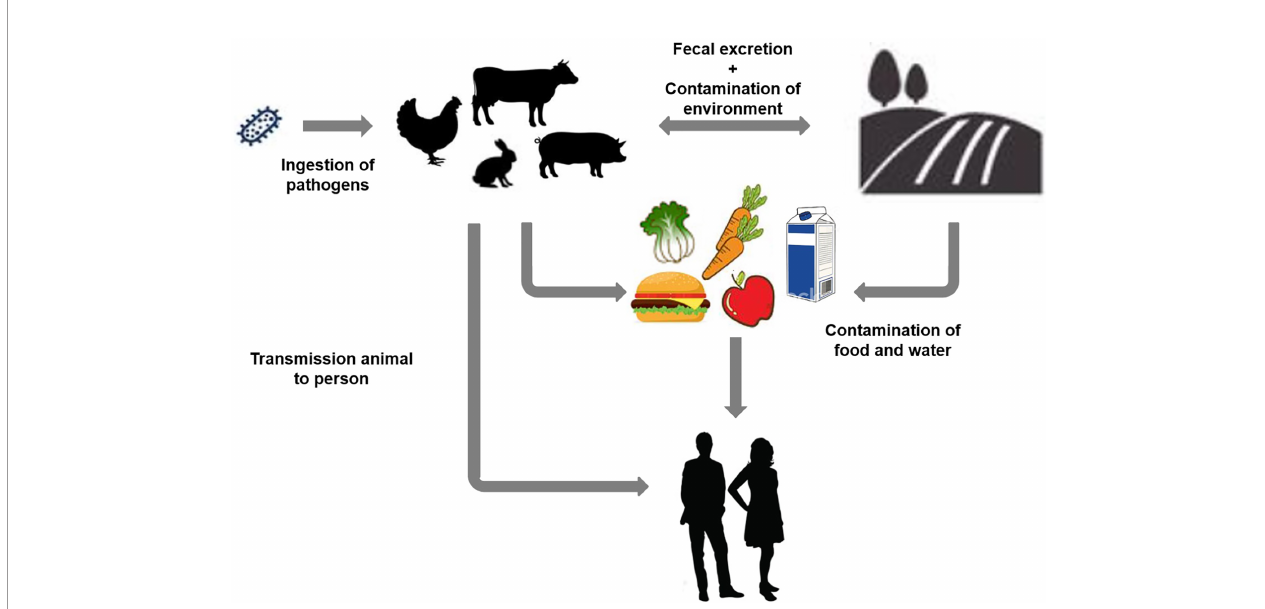
FIGURE 1 | Schematic representation of different contamination sources and transmission of Shiga toxin-producing Escherichia coli infection based on various environmental